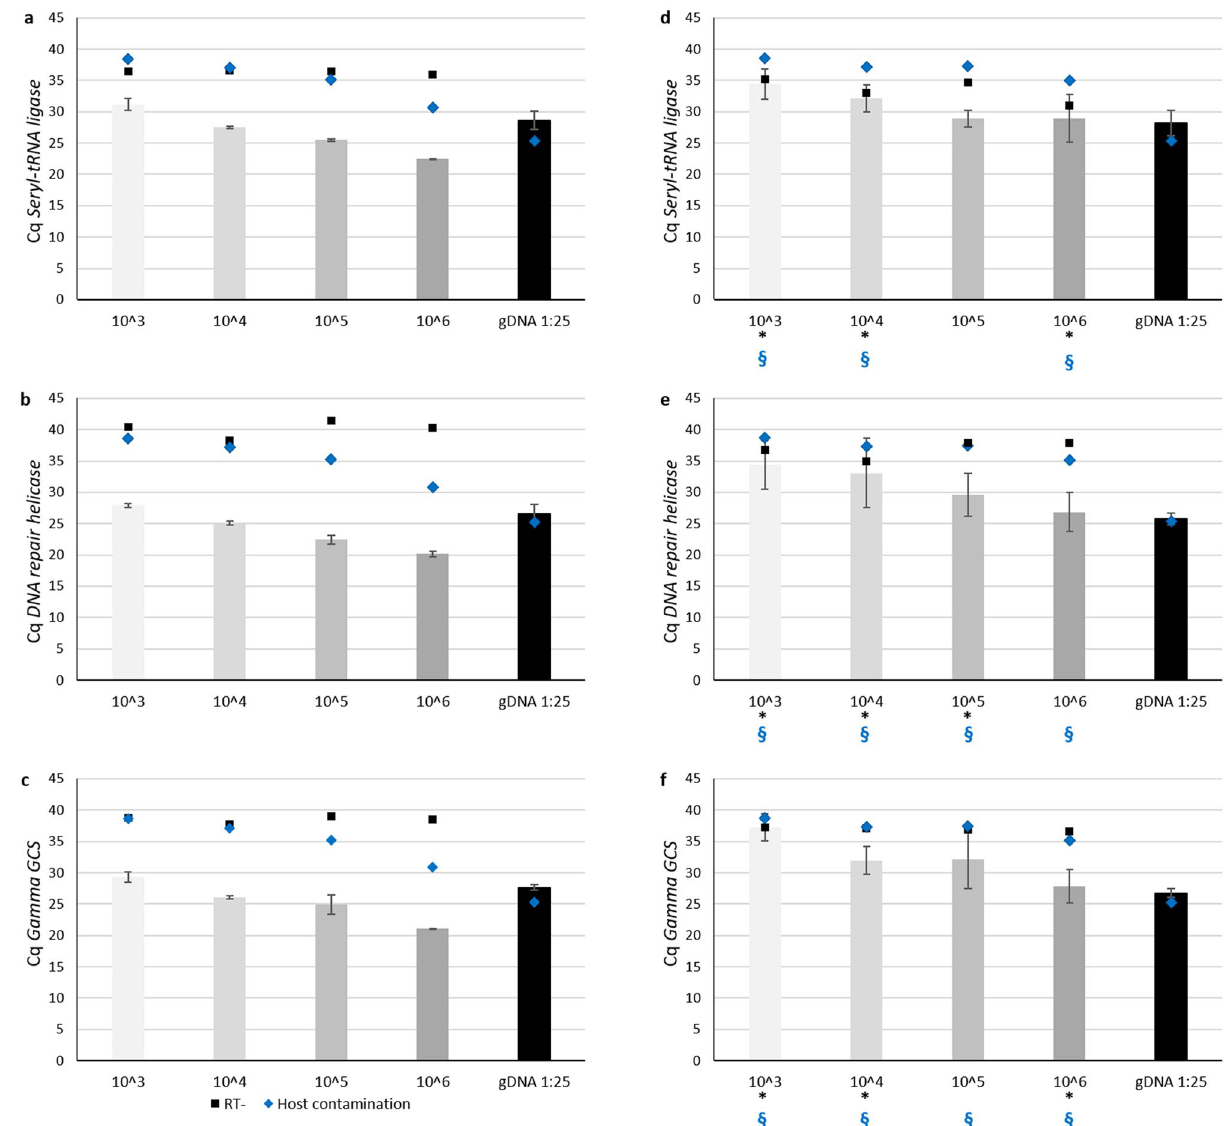
Figure 2. qRT-PCR of P. vivax total RNA samples. qRT-PCR amplification of housekeeping genes seryl tRNA synthetase ( a , d ), DNA repair helicase ( b , e ) and gamma-glutamylcysteine synthetase ( c , f ) , from the RNA samples of one Pv-iRT field-isolate (10 3 in light gray to 10 6 in dark gray), preserved in RNAlater or TRI Reagent and extracted by RNeasy Micro kit ( a – c ) or Direct-zol RNA MiniPrep ( d – f ), respectively. Bars and error bars represent the mean Cq and standard deviations (SD), respectively. Black square marks represent average Cq of RT- reactions, when amplification was observed before the last (45th) cycle stage. Blue diamond marks represent mean Cq amplification of human TLR9 gene for host contamination detection. Black * indicate when the mean Cq for each sample is higher than the limit of detection (3 times the Cq SDs from the correspondent RT- mean Cq) and blue § indicate when the mean Cq is higher than the mean Cq for host contamination detection (3 times the Cq SDs from the correspondent TLR9 mean against the corresponding RT- controls, and host contamination was reduced and not interfering in the qRT-PCR reactions (Supplementary Fig. S7). Combining those results, the RNeasy Micro kit was the most reliable option. P. vivax low input cDNA synthesis, library preparation and sequencing. RNA extractions of 7 different samples from 4 different P. vivax -infected reticulocyte (Pv-iRT) isolates (62U15, 66U15, 93U15 and 101U15) were performed using the RNeasy Micro kit and their quantity and quality evaluated by Bioanalyzer platform (Supplementary Fig. S8). To set guide thresholds for the minimal input requirements for RNA-seq, a control sample was included, with approximately 10 6 parasites trophozoite staged of P. falciparum S20 strain 32 . On average 101.5 pg.µL −1 of RNA, ranging from ~ 10.5 to ~ 522 pg.µL −1 , was obtained (Supplementary Table S2). For P. falciparum S20 strain, the lowest amount of total RNA (~ 1.2 pg.µL −1 ) was acquired. Following previous observations, RIN score often fail due to low quantities of RNA (Supplementary Table S2 and Fig. S8). Given the